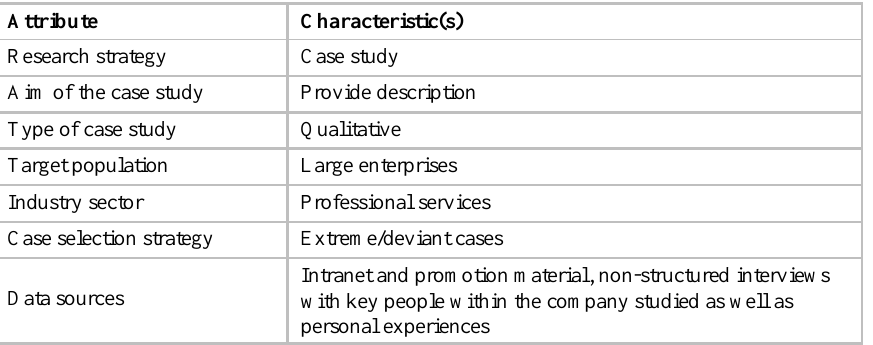
Table 2. Research design